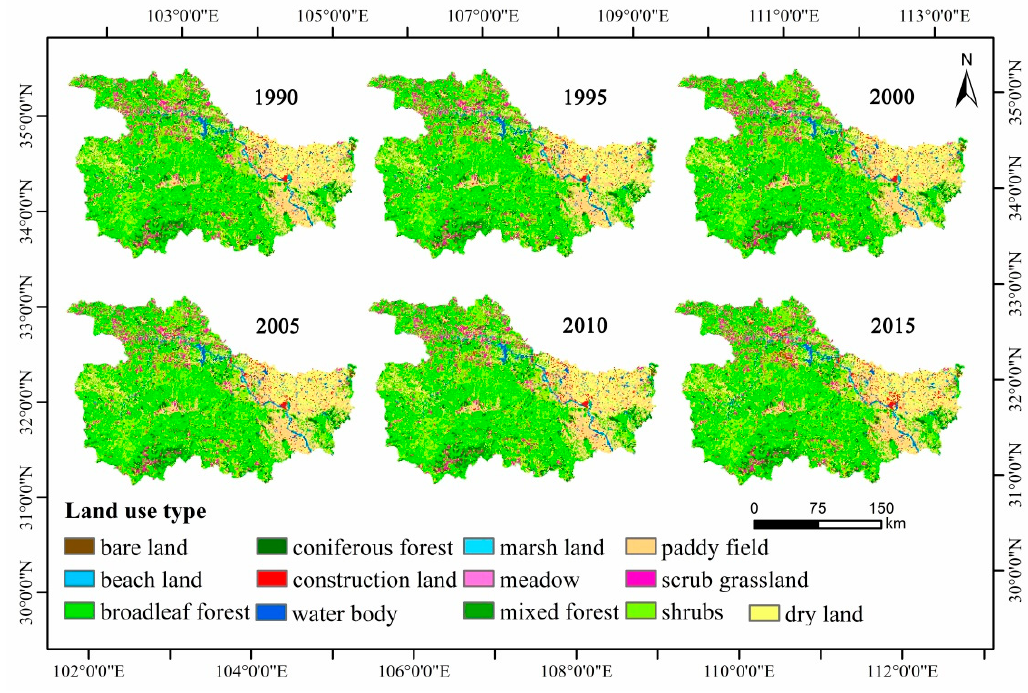
Figure 2. Land use types of the Exibei Region in 1990–2015.